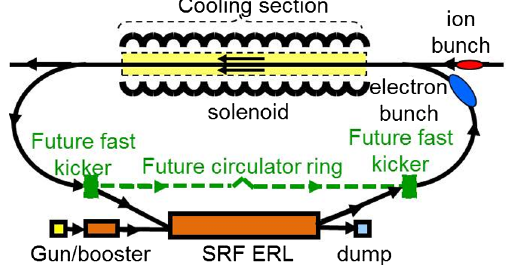
FIG. 1. Schematic of ERL-based bunched beam cooler (black solid) with option for future recirculation path (green